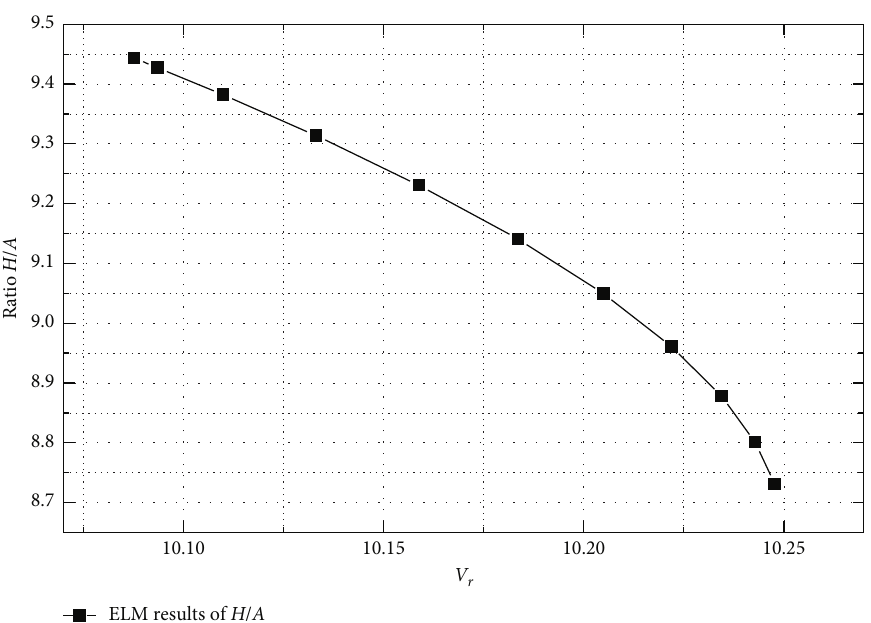
Figure 7: Curve of frequency and amplitudes of LCOs.